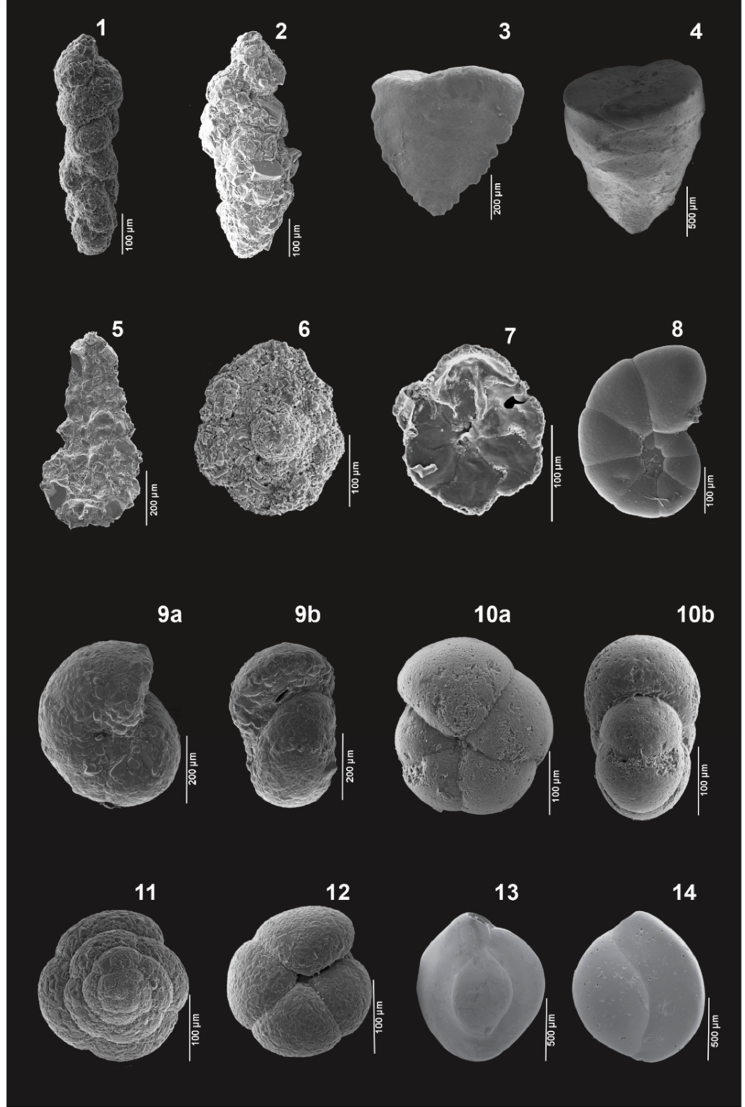
Figure A2. Plate II: 1— Karrerulina conversa (Grzybowski, 1901), side view; 2— Karrerulina sp. A, side view; 3— Textularia truncata Höglund, 1947, side view; 4— Textulariella barrettii (Jones & Parker,